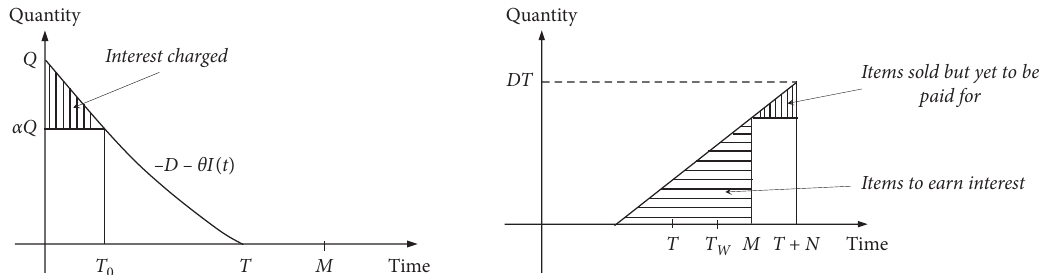
Items sold but yet to be paid for